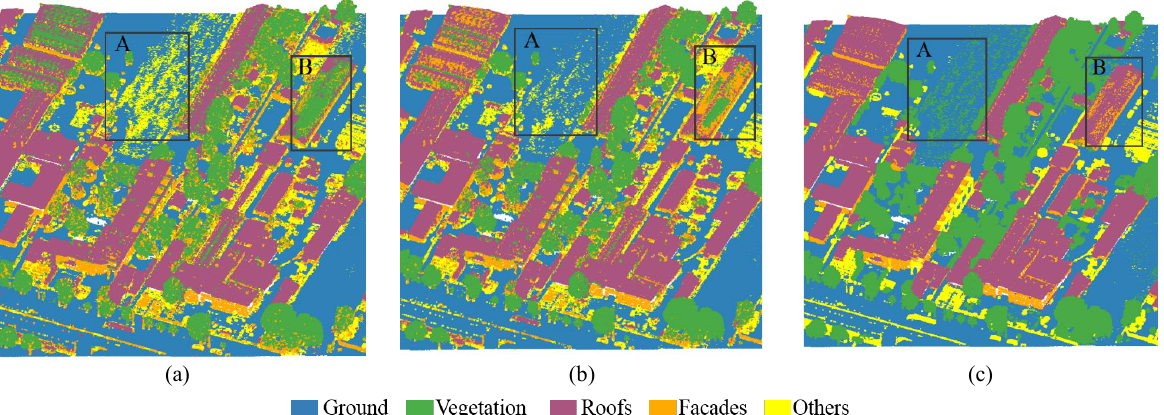
Figure 2. Detailed comparison of classification results. (a) using the initial training dataset; (b) using the extended training dataset; (c) the reference labelled